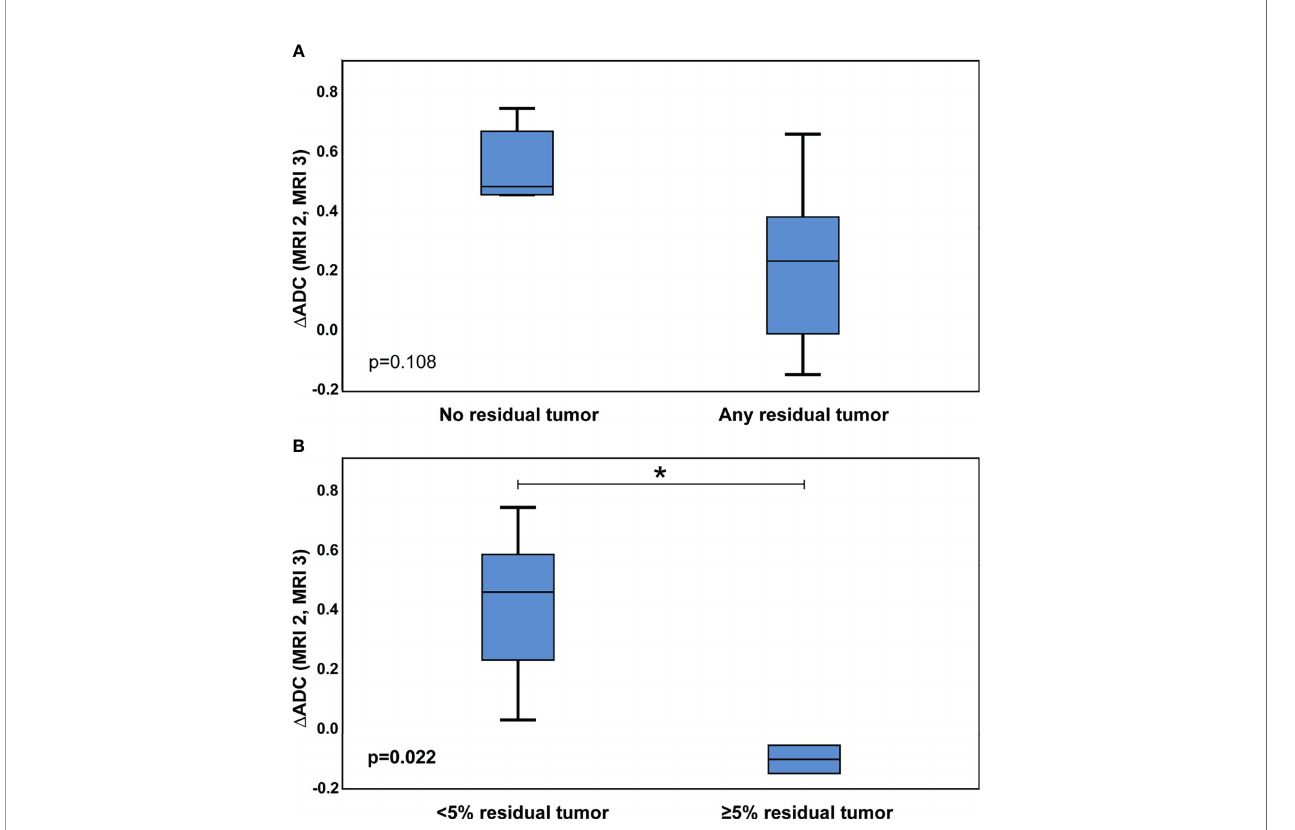
FIGURE 3 | Association ofChanges in ADCSignal Intensities with PathologicalTumor Response. Delta ( D ) inADC signalintensities of MRI 2 and MRI 3 correlatedwith pathological response of the primary tumor: (A) D ADC, complete response of the primarytumor vs. anyresidual primary tumor; (B) D ADC, <5% residual primarytumor vs. ≥ 5% residual primary tumor; ADC, Apparent diffusion coef fi cient; MRI, Magneticresonance imaging; p-values accordingto Mann-Whitney U test; *p-value<